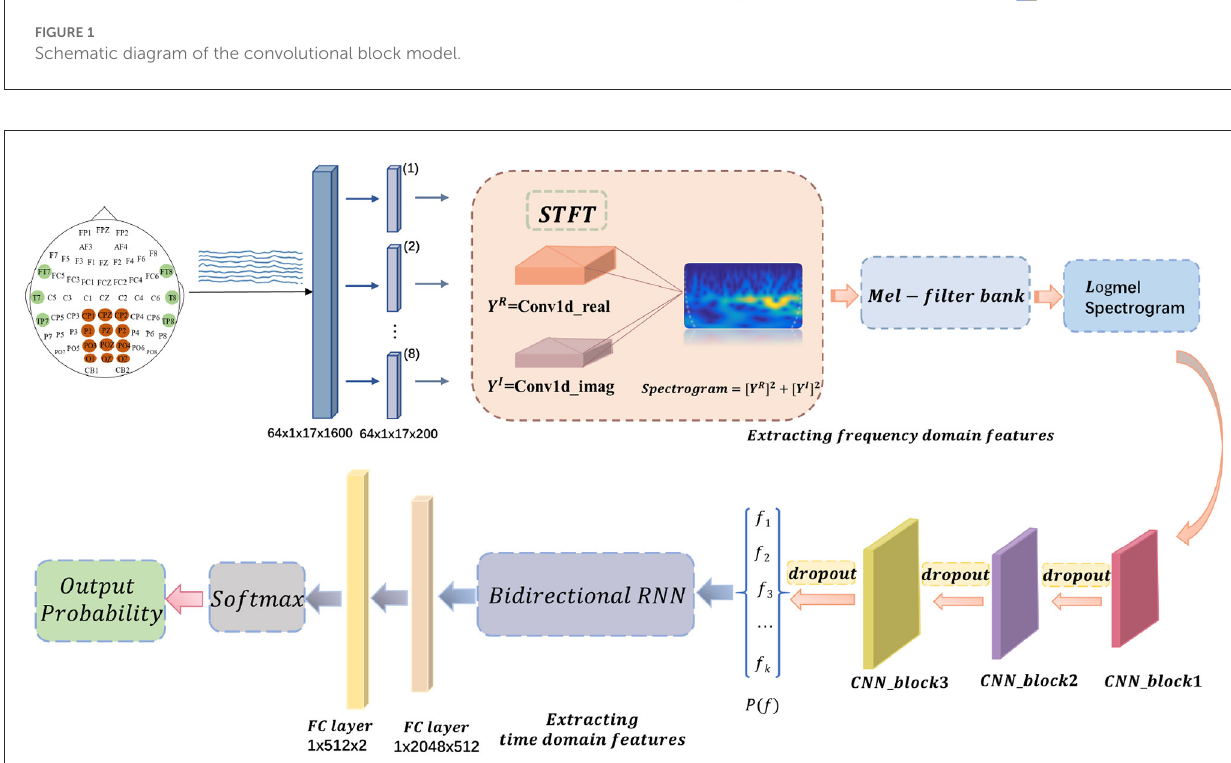
FIGURE2 Schematic diagram of the whole model of the proposed LogMel-CRNN